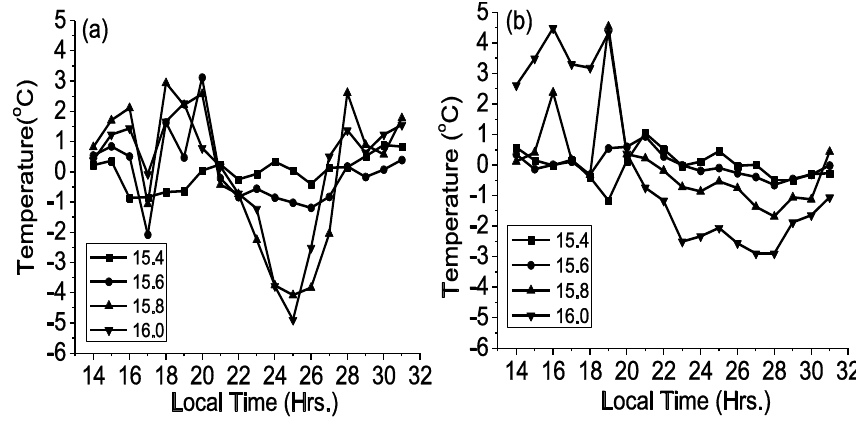
Fig. 6. Temporal variation of temperature in the upper troposphere (near tropopause region) from 15.4km to 16.0km height at 200m height interval for convection days (a) on 30 November 2005, (b) on 9 December 2005. Here we have shown mean removed fluctuations.